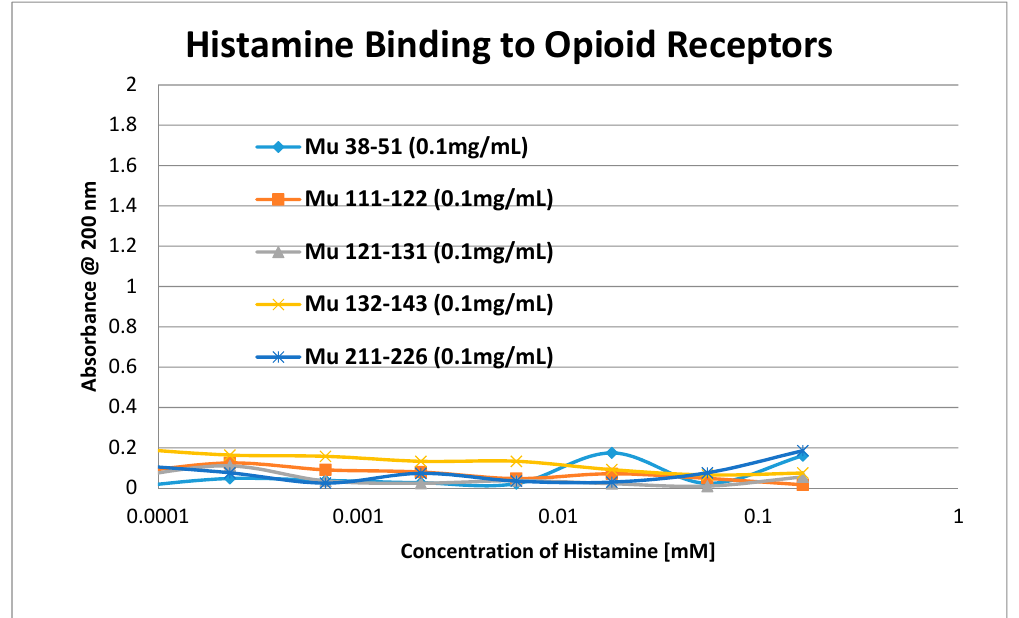
Figure 3. UV spectroscopic study of histamine binding to mu opioid receptor (muOPR) peptides derived from the extracellular loop and adjacent transmembrane regions (see Figure 1). Int. J. Mol. Sci. 2018 , 19 , 272